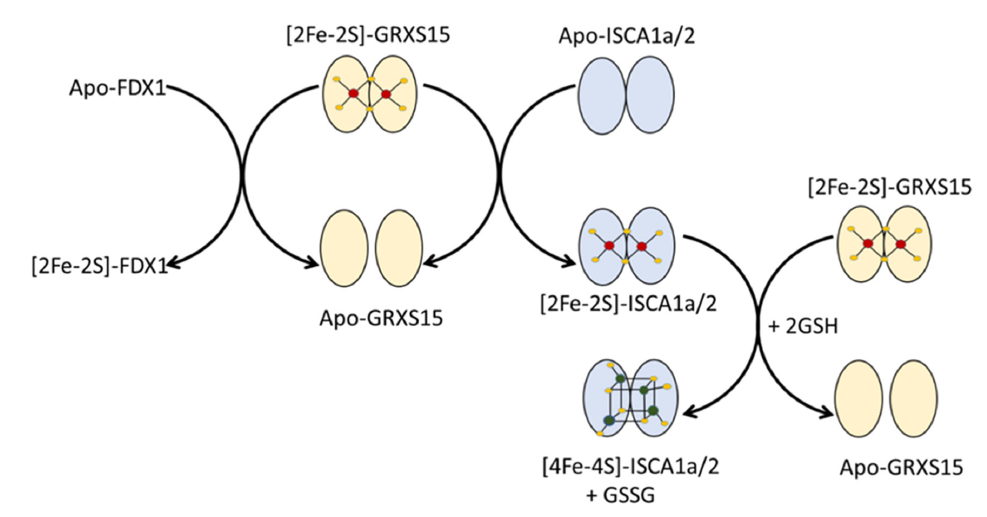
Figure 10. Summary scheme for cluster trafficking between GRXS15 and its partner proteins .